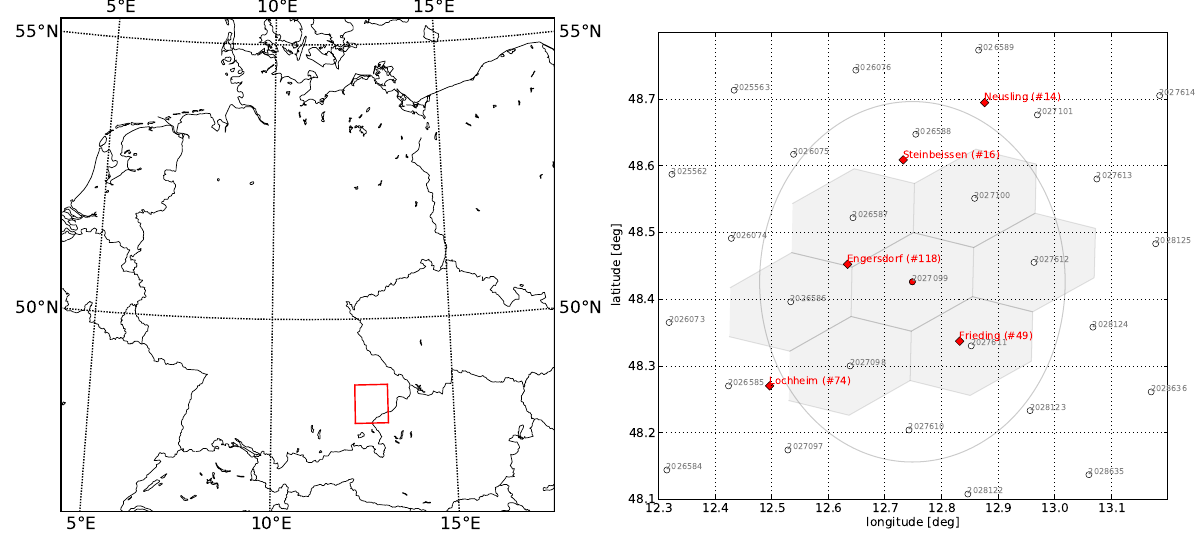
Fig. 1. Location of test site (left) and details of used in situ stations and their mapping to the ISEA grid. The polygons correspond to ISEA grid cells used for the analysis of land surface model simulations. The circle corresponds to the AMSR-E like footprint size.